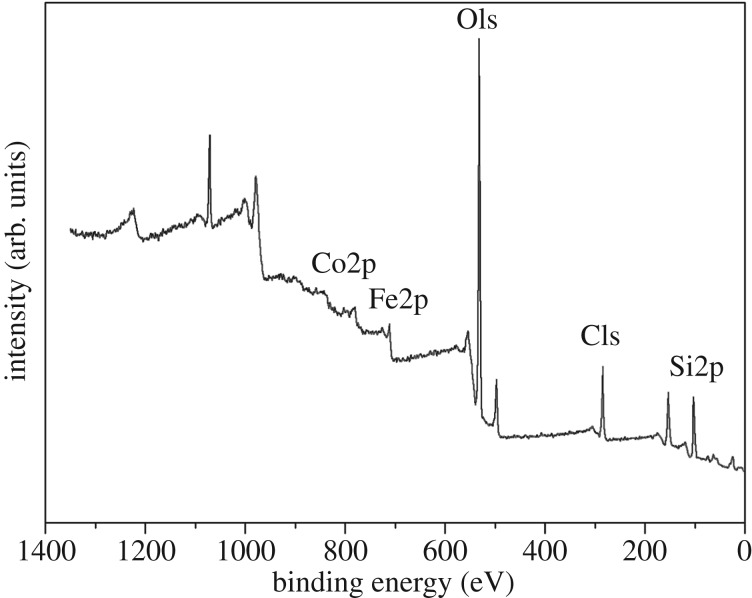
X-ray photoelectron survey spectrum of CoFe2O4–SiC foams.